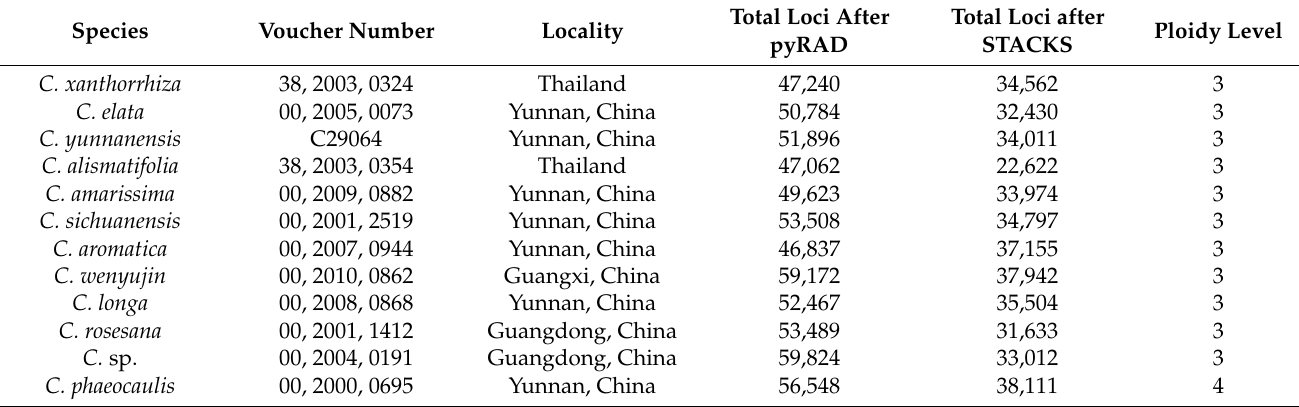
Table 1. List of 12 Curcuma species names, with source details and total loci after processing with ipyRAD and